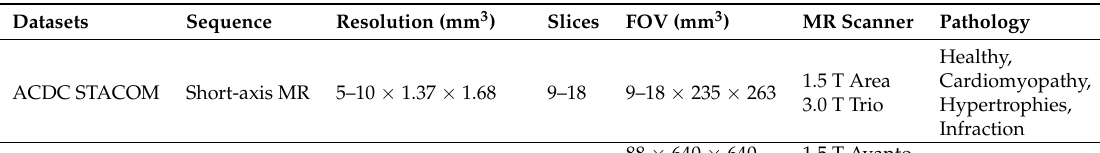
Table 1. Imaging parameters of the sequences employed in this study. Abbreviations: FOV, field of view.